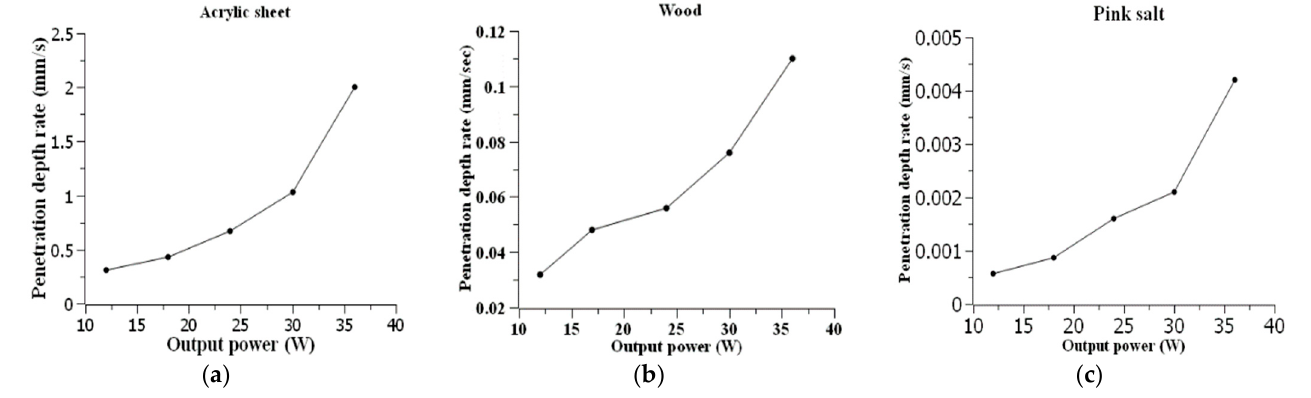
Figure 5. Beam penetration rate along with output power ( a ) acrylic sheet (PMMA) ( b ) wood ( c ) rock of pink salt.